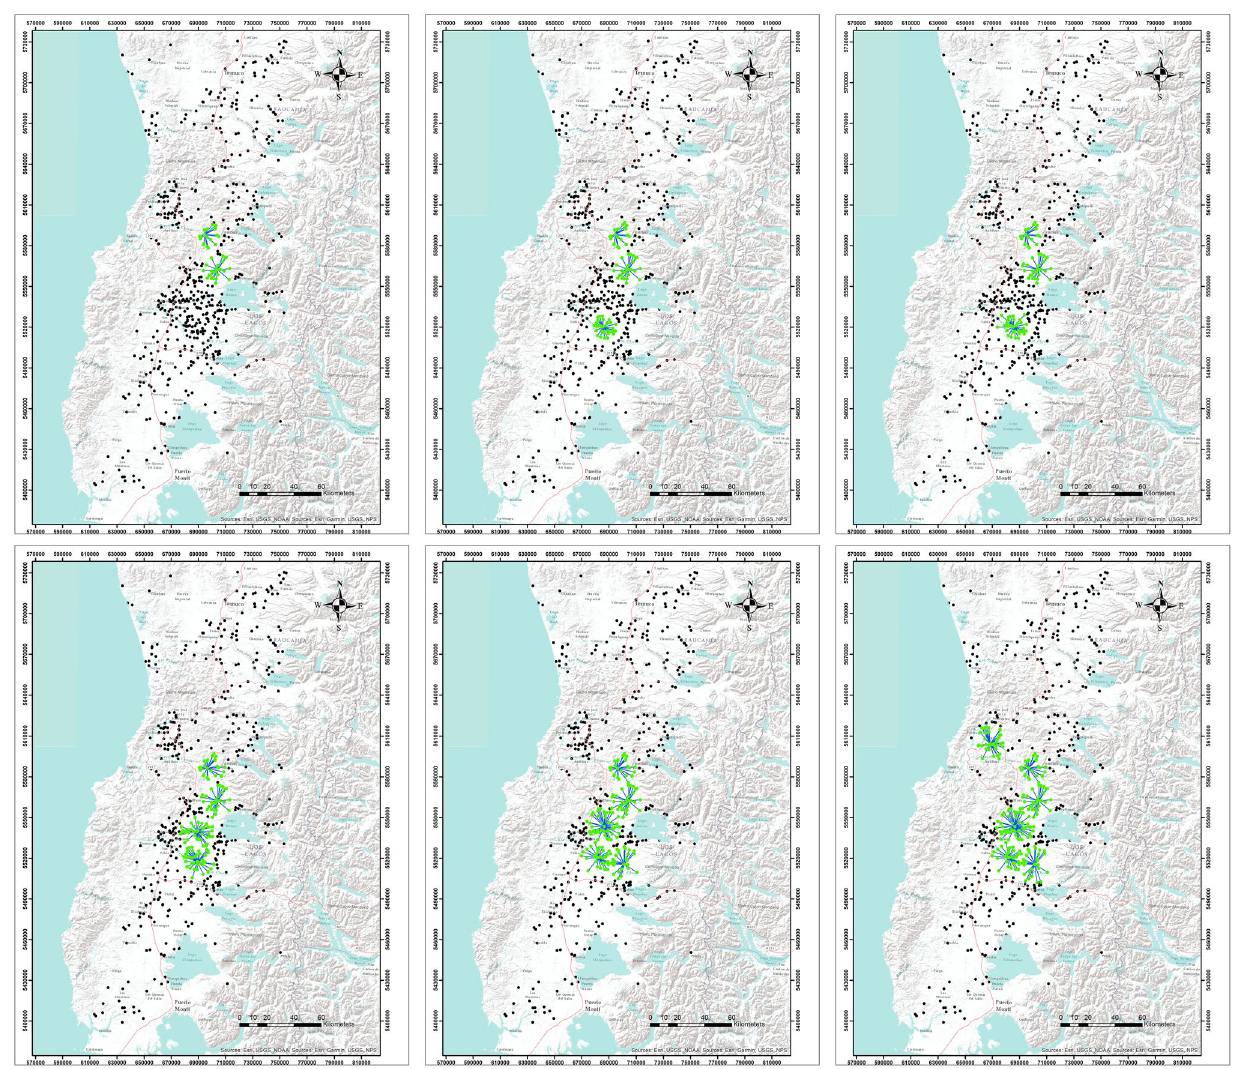
Fig. 14 Location of the configurations of the best combination found, with 80% biomass availability scenario, transport cost of 0.4 USD/tkm, and energy price of 90, 92, 94, 96, 98 and 100 USD/MWh, in order of